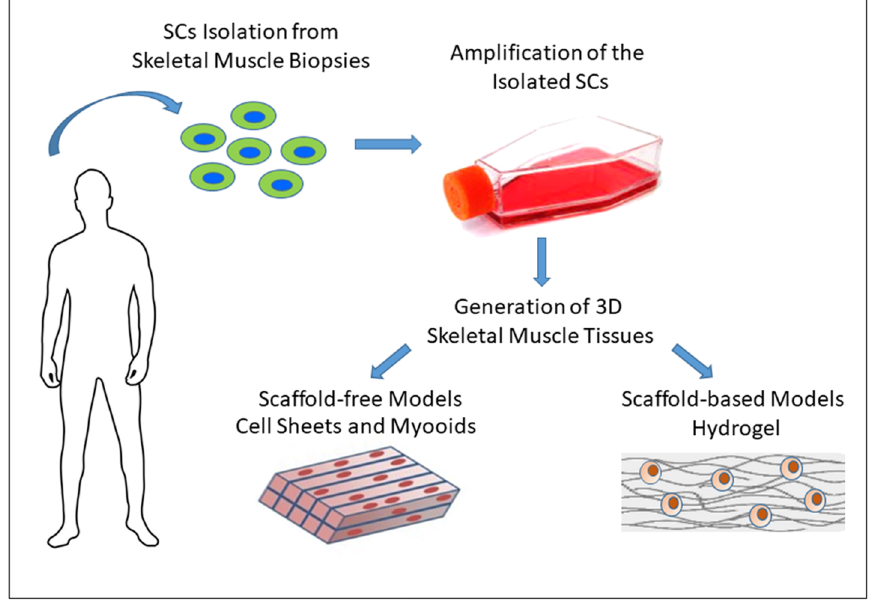
Figure 2. 3D cell-tissue engineered approach for in vitro skeletal muscle investigations. Engineered skeletal muscle models are based on 3D systems of cells scaffold-free or generated by combining cells and an appropriate scaffold.